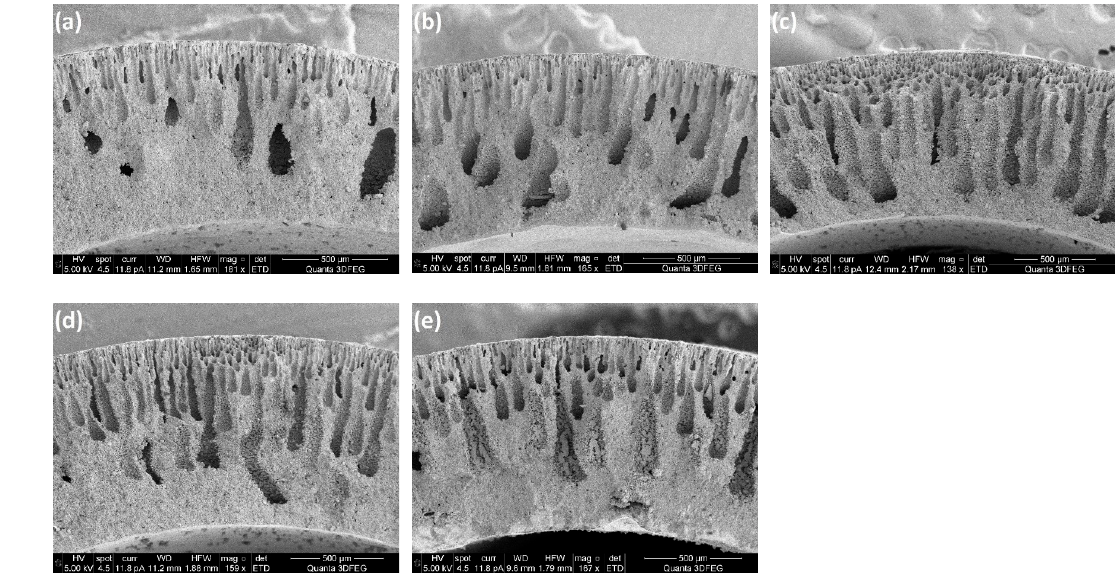
Figure 11. SEM images of MgO-CGO supports fabricated from slurries with ( a ) 11 wt%, ( b ) 15 wt%, ( c ) 18 wt%, ( d ) 22 wt% and ( e ) 25 wt% polymer concentration with a fixed ceramic loading of 43 wt%.